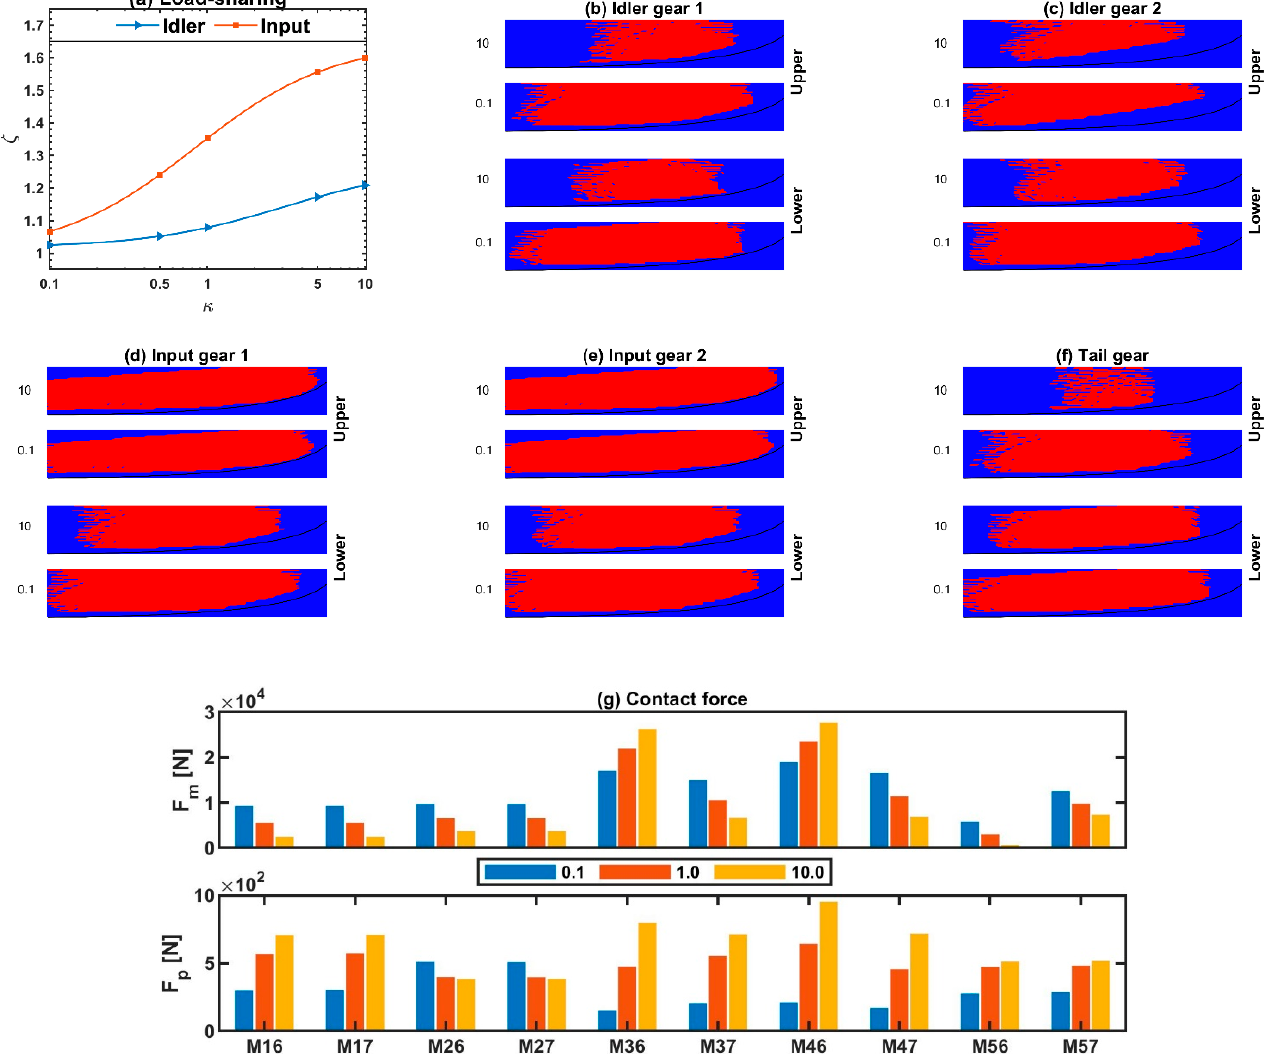
Figure 9. Influence of the support stiffness of the input gear on the load-sharing and contact char- acteristics.